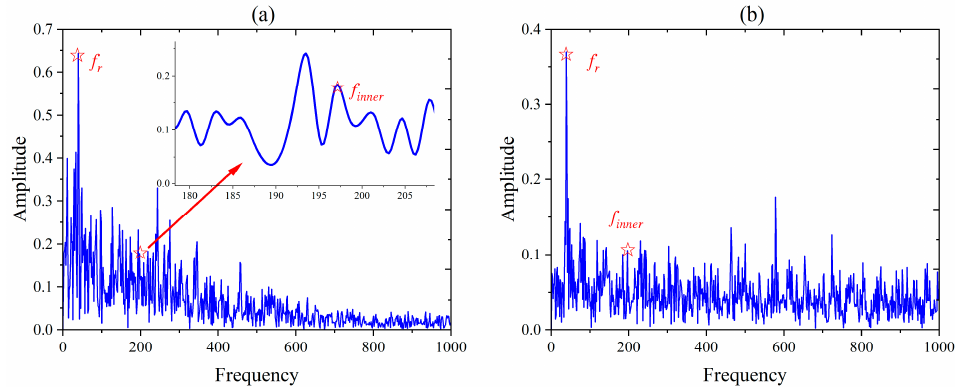
Figure 19. ( a ) The best PF in the RLMD envelope spectrum, and ( b ) The best PF in the CCERLMDAN envelope spectrum.